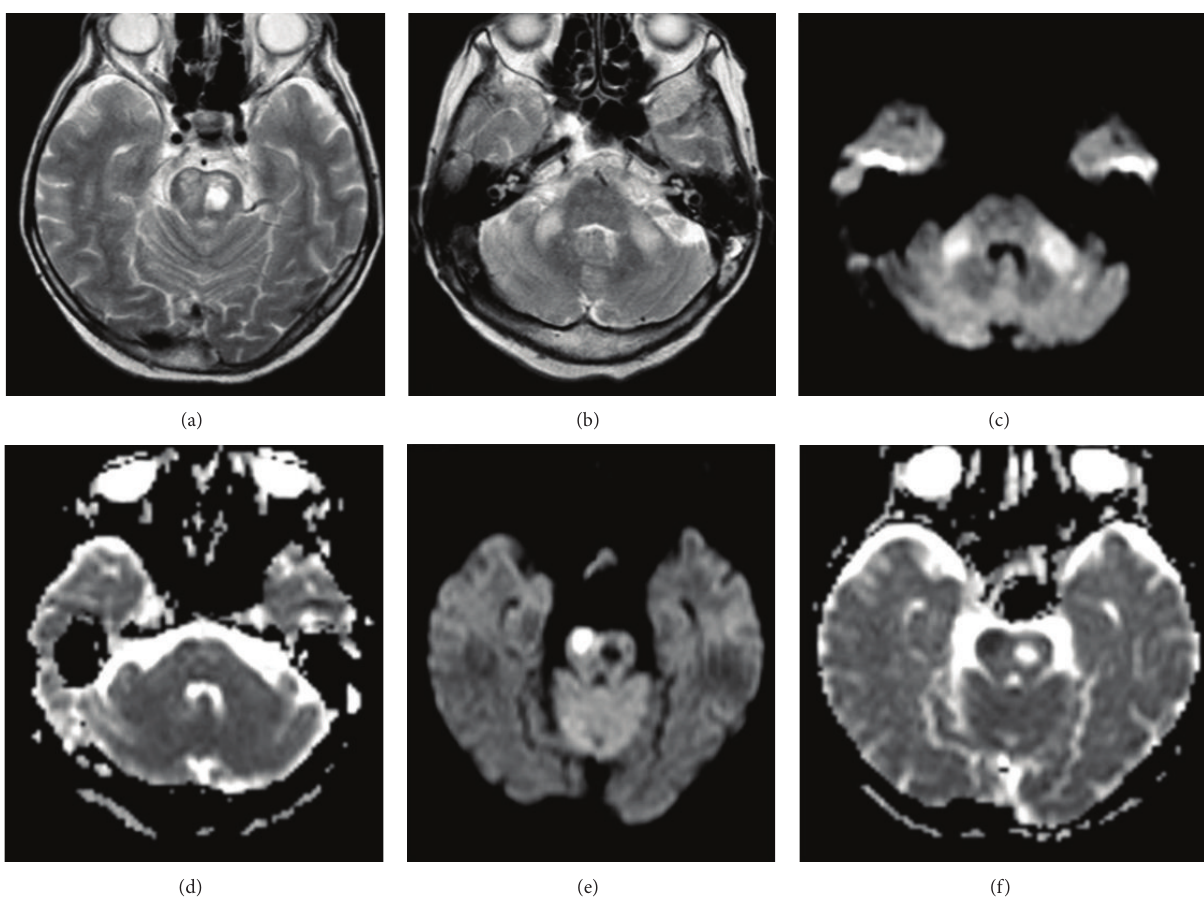
Figure 2: 3 months after left paramedian acute pontine infarction. Axial T2WI (a) hyperintense signal in pons due to chronic infarct. Axial T2WI (b) bilateral and symmetrical hyperintense signal in MCPs due to WD. Axial DWI (c) and ADC map (d) shows hyperintense signal. Axial DWI (e) and ADC map (f) shows restricted diffusion due to new acute infarct in the right side of the